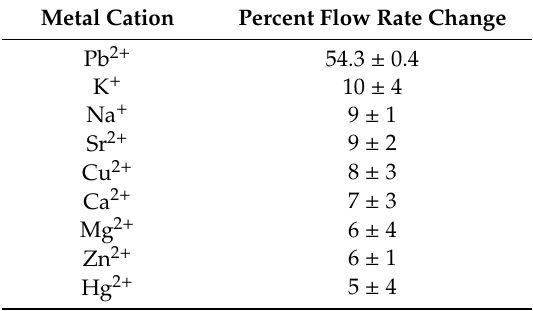
Table 2. Percent volumetric solution flow rate change measured after addition of the indicated cation. Reprinted and adapted with permission from [13]. Copyright 2018, American Chemical Society.